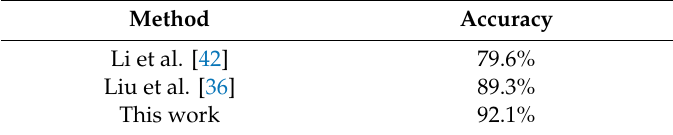
Table 9. The performance of classification accuracy with di ff erent